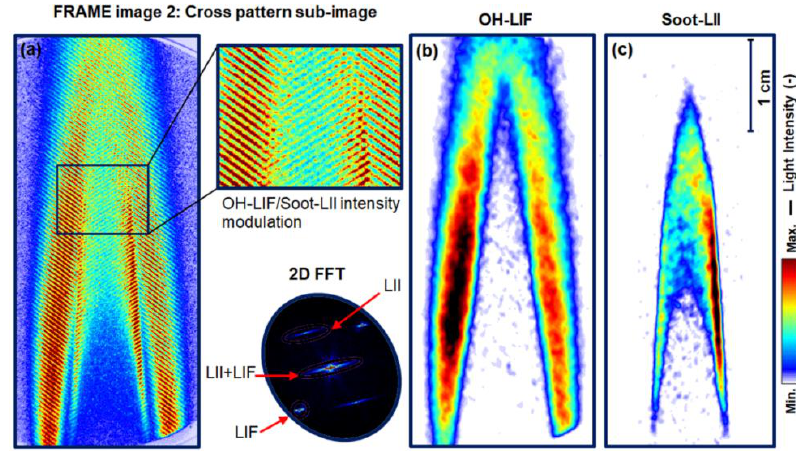
Figure 6. ( a ) Single-shot FRAME image: cross-patterned unprocessed sub-image and its FFT consisting of modulated signals of OH-LIF and soot-LII. Processed OH-LIF image in ( b , c ); the soot-LII image of the flame is extracted using the lock-in algorithm in ( a ). The signal reduction due to laser extinction is seen here from left to right in OH-LIF and from right to left in soot-LII. Qualitatively, most of the OH occurs in the reaction zone and soot-oxidation zone of the flame, whereas the soot is distributed in the internal zone and the secondary reaction zone.